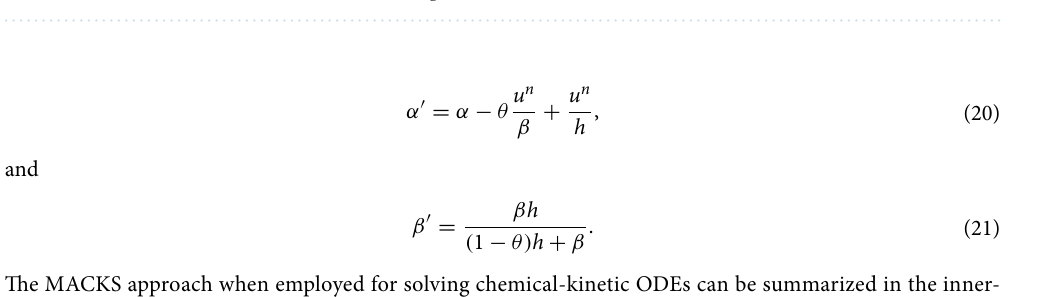
Figure 4. Total computational cost ratio of LLNL, ERENA, and MACKS for the H 2 /air and CH 4 /air— n - C 12 H 26 / 8 7 air mixtures where h = 1 × 10 − and 1 × 10 − , p 0 = 0.1 and 1 MPa, and T 0 = 1300K